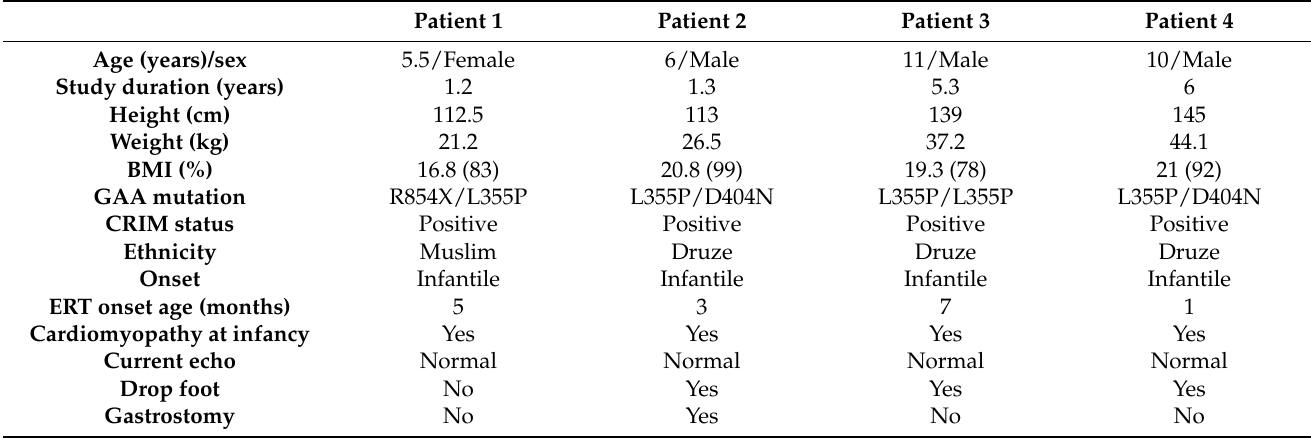
Table 1. Demographics and characteristics of the study population at first evaluation.